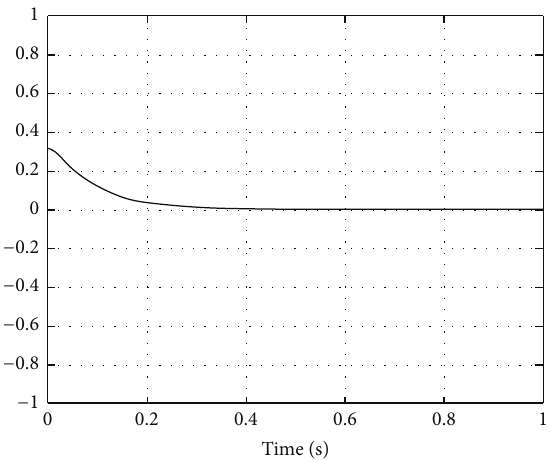
Figure 2: The output angular position 𝑥 1 (𝜃 1 ) of the two inverted